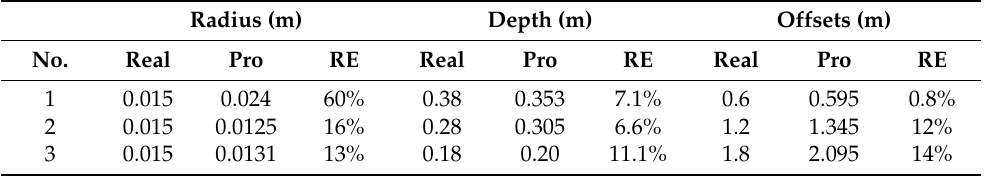
Table 3. Radius and location estimation of the multi